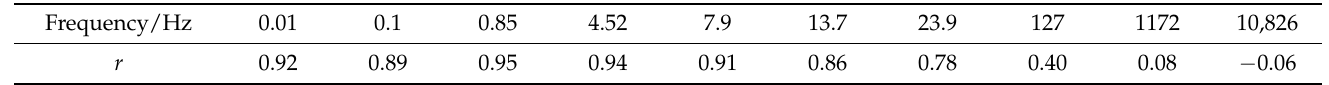
Table 6. Pearson’s correlation coefficient ( r ) between the phase angles and | Z | 0.01Hz for T700/BMI.